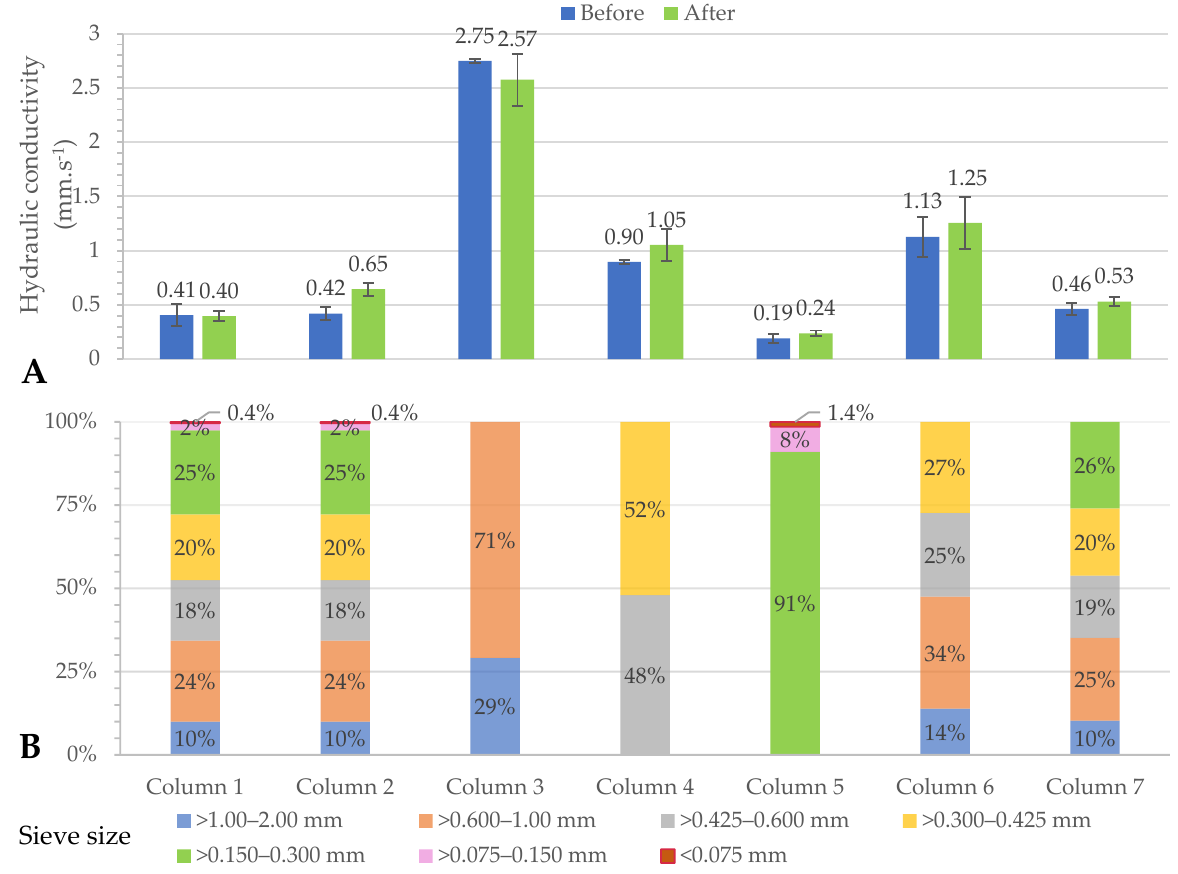
Figure 5. Measured hydraulic conductivity in sand columns before and after calcite dissolution ( A ), and the distribution of grain size fractions in the columns ( B ). The bars from plot A are aligned vertically with those from plot B, both representing columns 1 to 7.